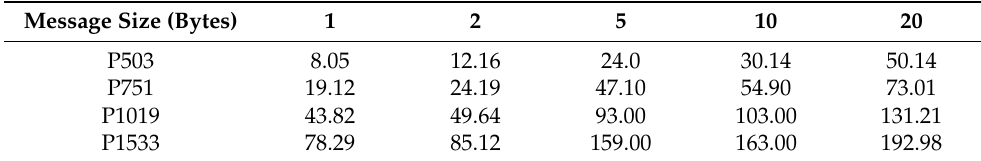
Table 6. Message size vs. time (ms) for different p values.